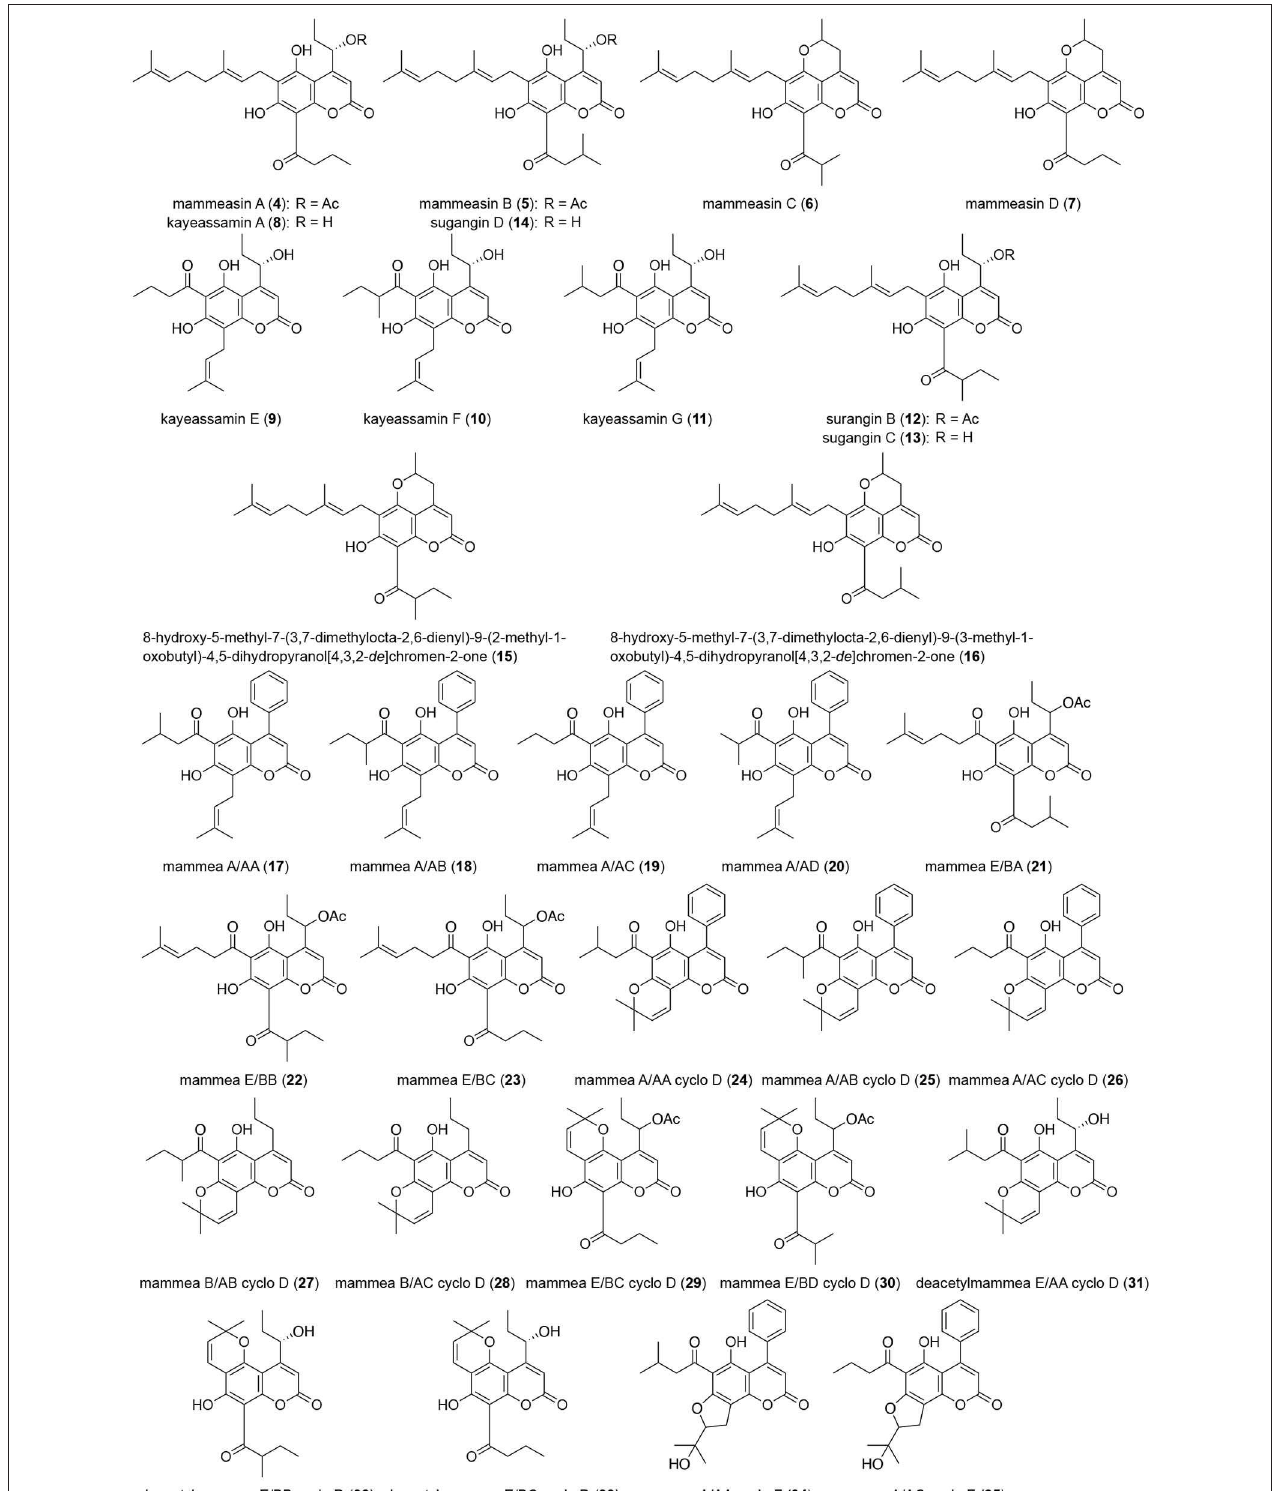
FIGURE 2 | Coumarin constituents (4–35) from the flowers of M. siamensis .